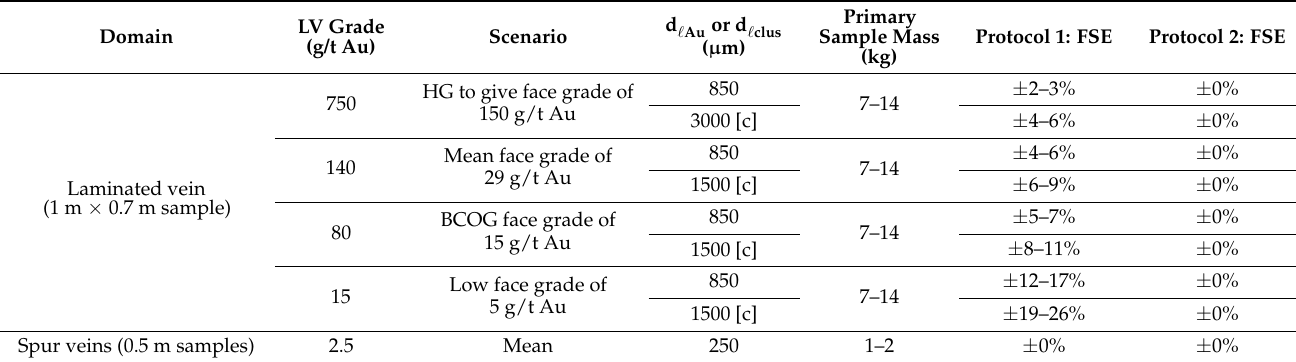
Table 25. FSE values for the new optimised sampling protocols using PhotonAssay by vein domain for different